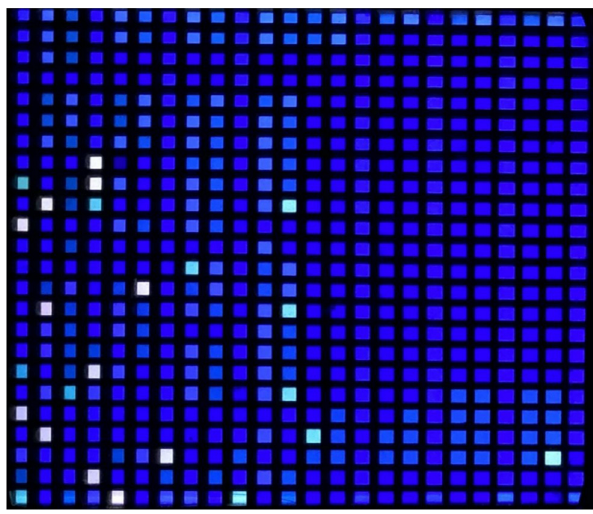
Figure 2. Optical processor result graph.